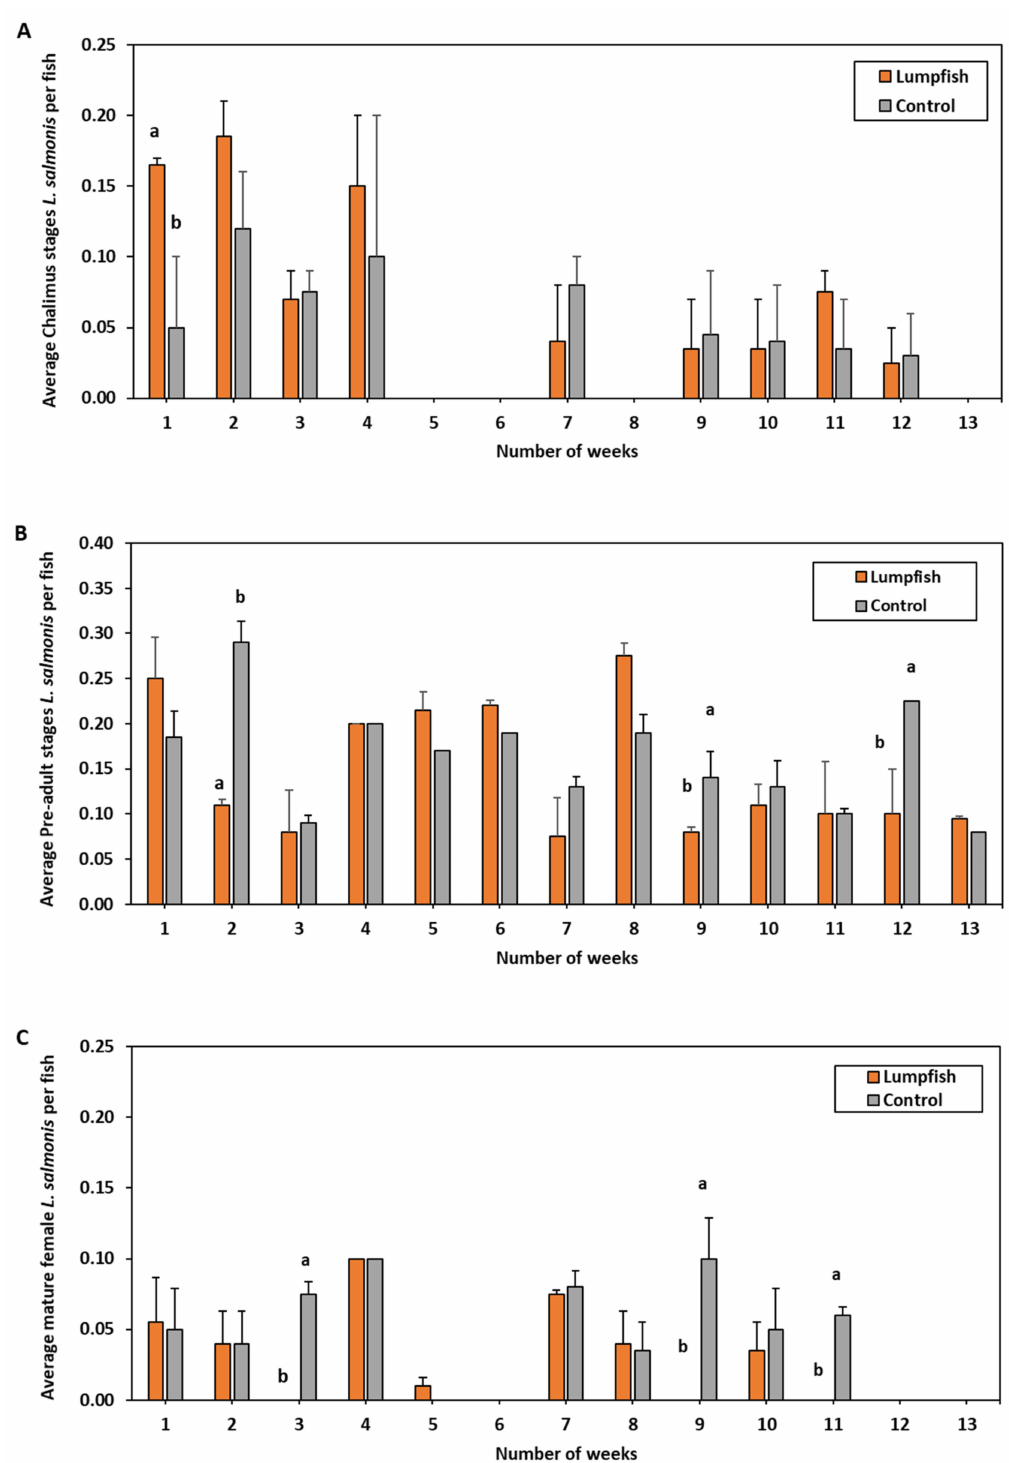
Figure 6. Mean occurrence of the chalimus ( A ), pre-adult ( B ), adult female ( C ) stages of L. salmonis per salmon (N = 60) in sea cages with lumpfish present and without lumpfish (Control) at the Røssøy facility. Values are presented as means ± SE. Different letters indicate significant differences (SNK post hoc test) between cages with and without lumpfish present. Previously unpublished